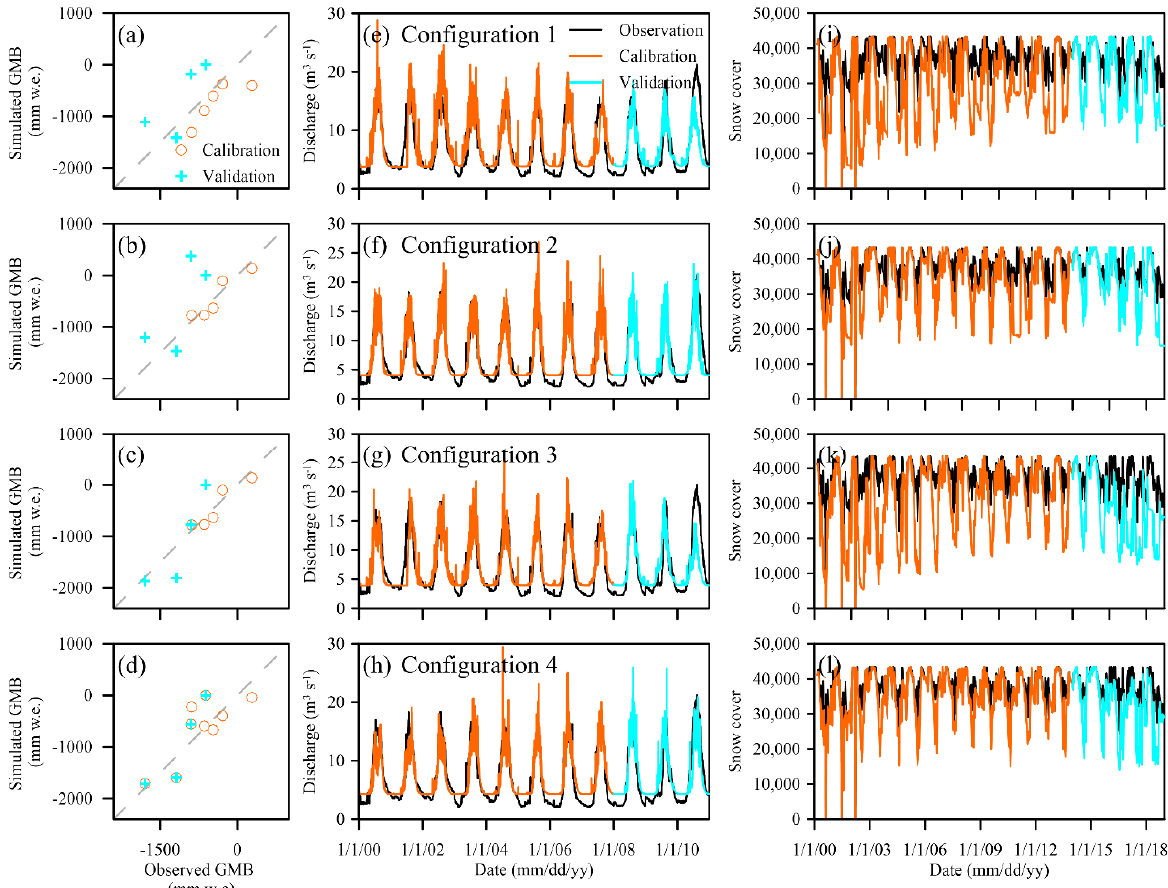
Figure 2. Simulated glacier mass balance ( a – d ), runo ff ( e – h ) and snow cover ( i – l ) using the four con fi gurations in the Kyanjing basins compared to observations; the model results in the four rows correspond to Con fi gurations 1–4, respectively.